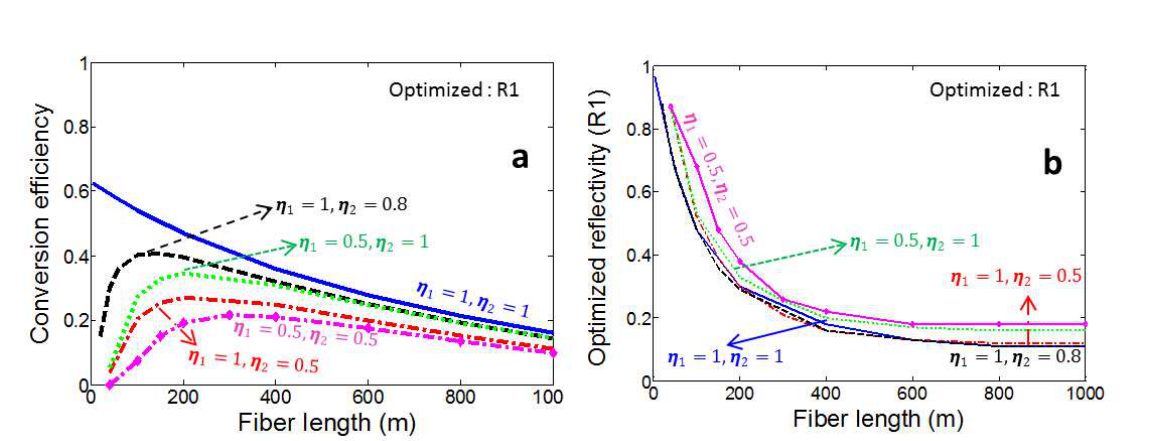
and η ); ( b ) optimum reflectivity of the 1 2